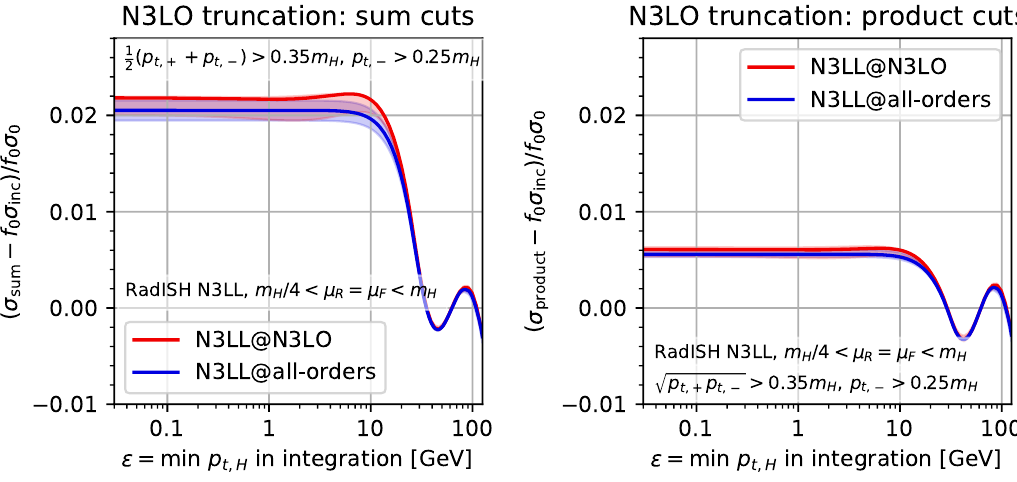
Figure 5 . The N3LL resummed result and its N3LO truncation, for sum cuts (left) and product cuts (right), as a function of (cid:15) , the minimum p t, h in eq. (2.22). Note the different scale relative to figure